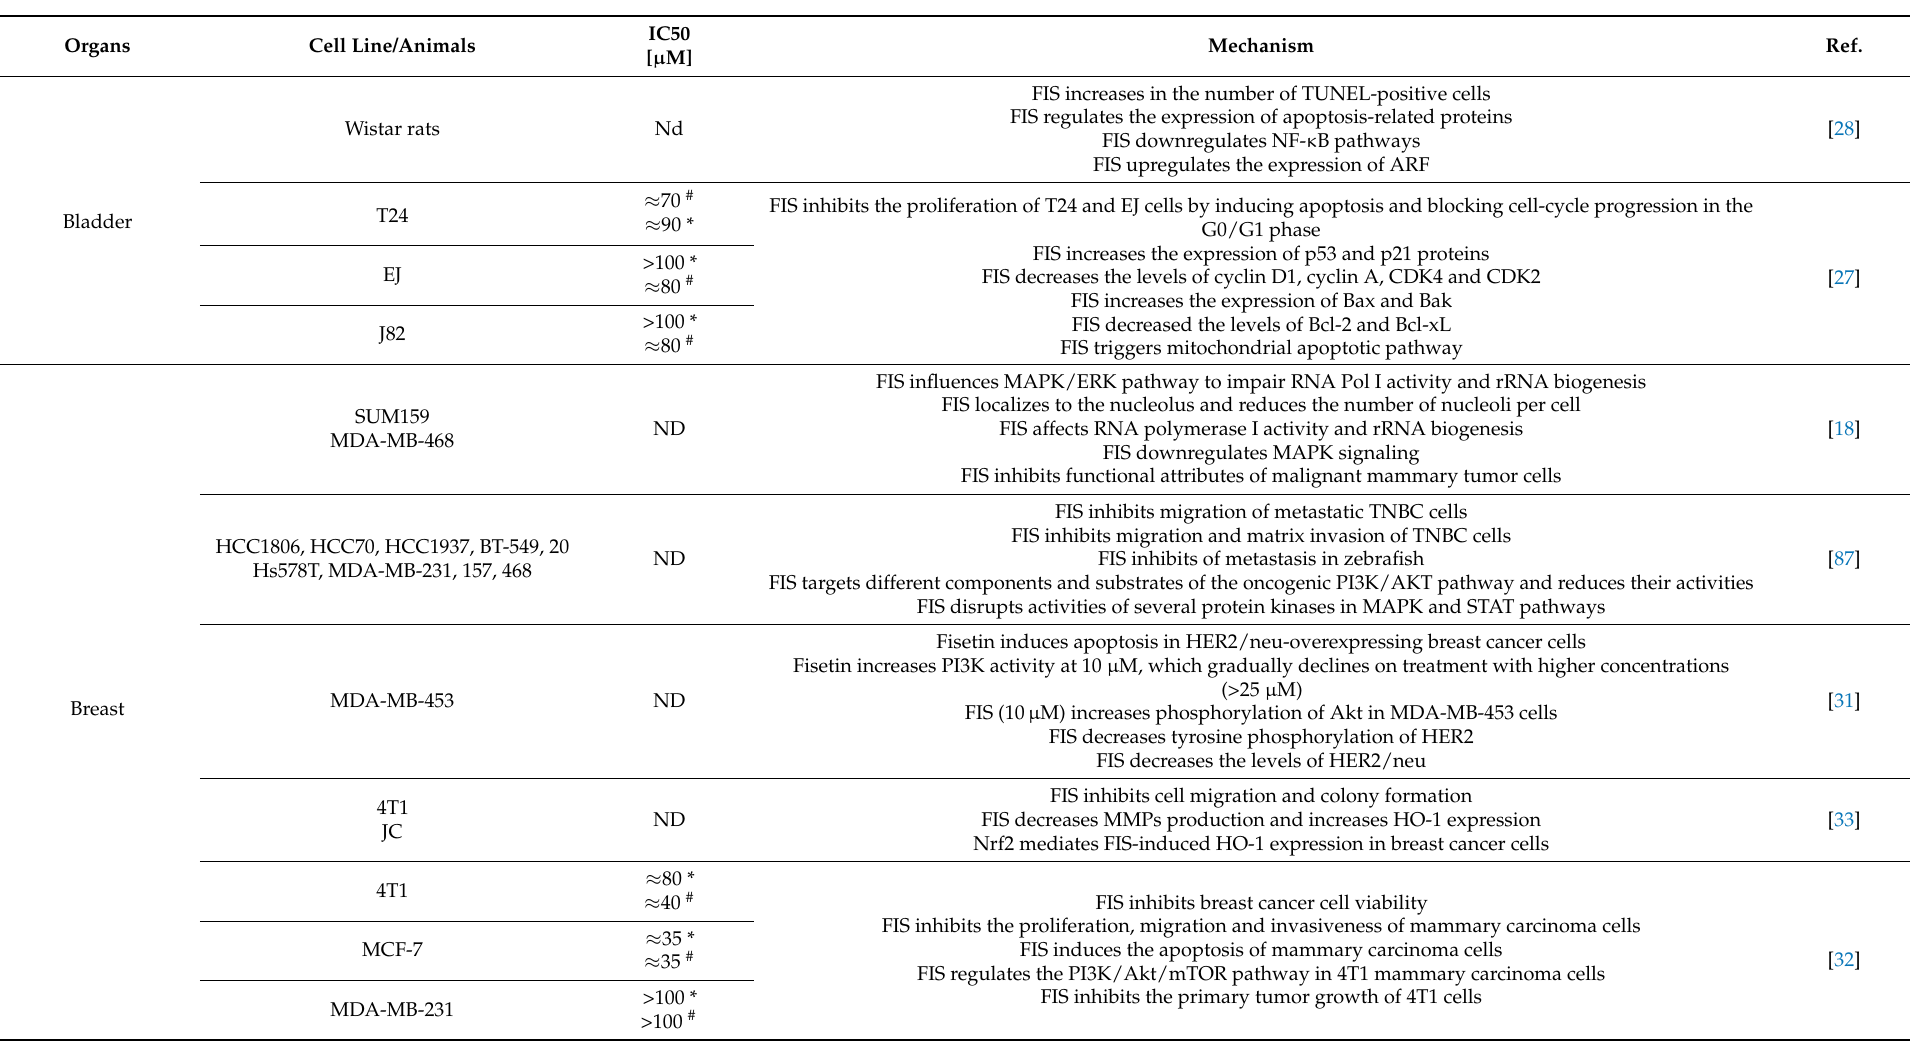
Table 1. Anticancer mechanisms of